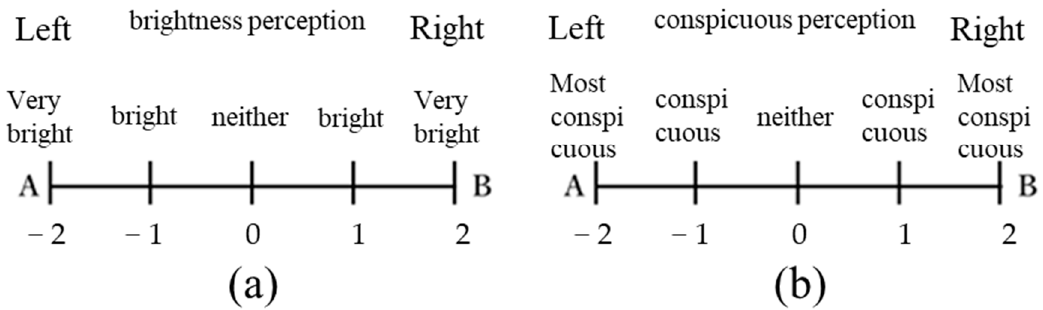
Figure 5. Evaluation items (English version). ( a ) Brightness evaluation sheet. ( b ) Conspicuity evaluation sheet. Compare the two samples and circle the item for brightness and conspicuity.